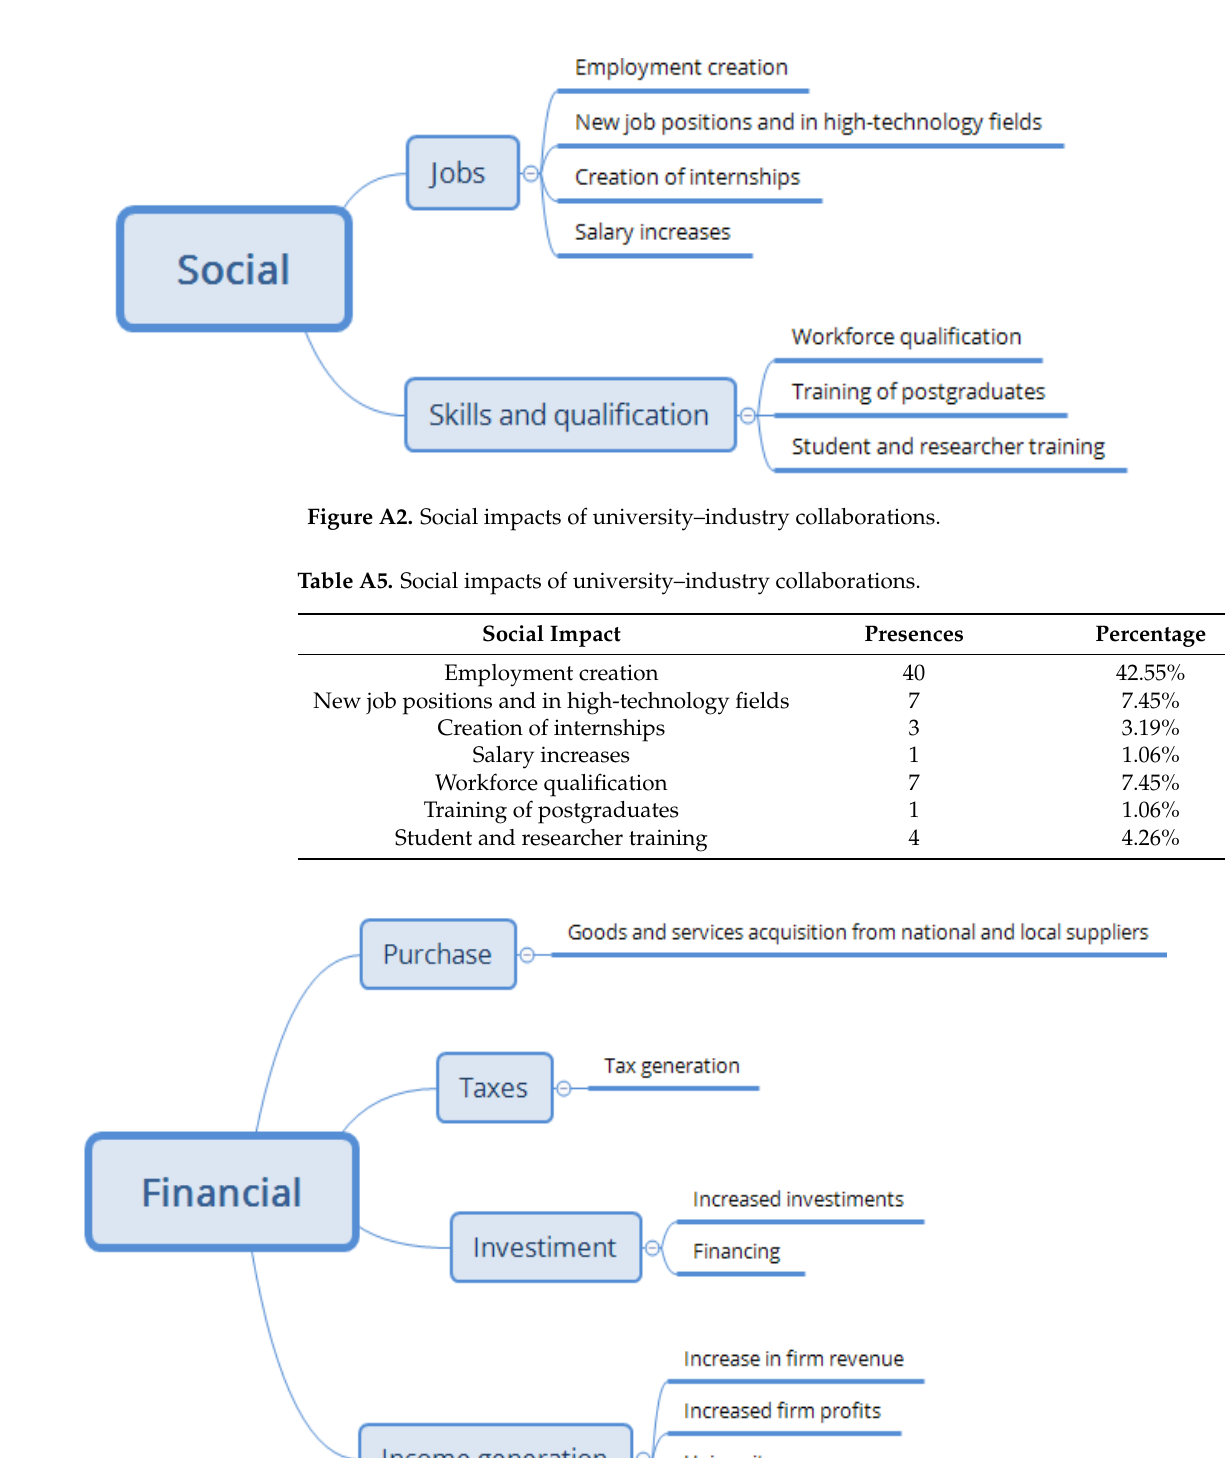
Figure A3. Financial impacts of university–industry collaborations.